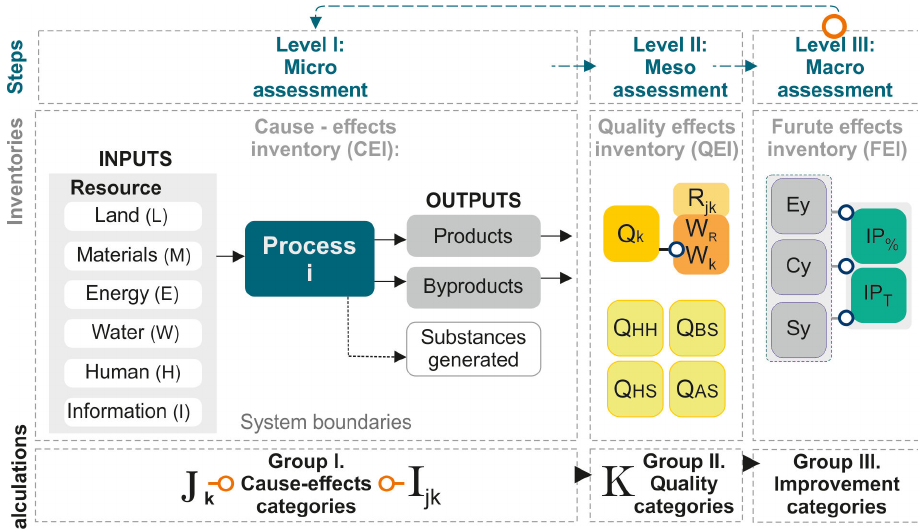
Figure 3. Classification of categories and information